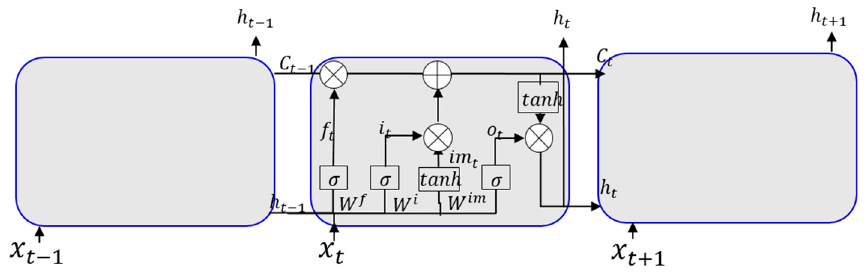
Figure 7. Structure of the long short-term memory (LSTM) model.